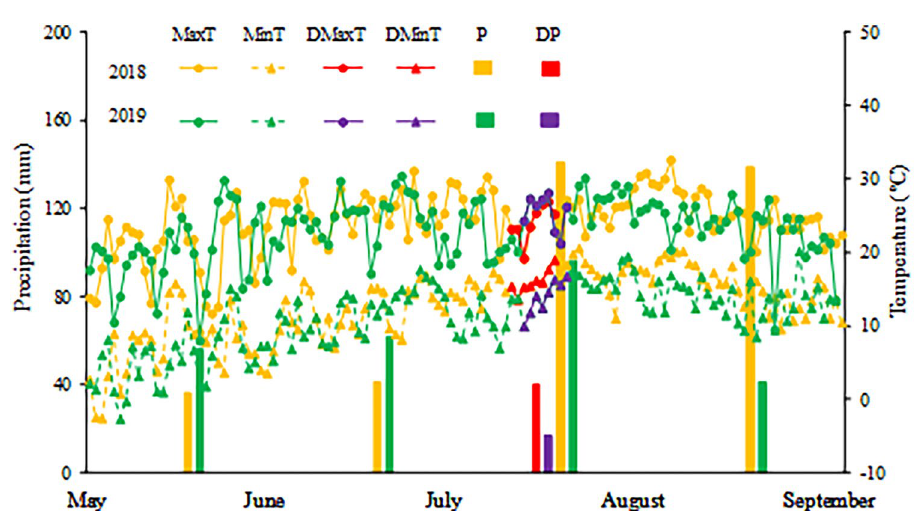
Figure 1. The maximum temperature (MaxT), minimum temperature (MinT) and month total precipitation (P) during the naked oat growing season, and maximum temperature (DMaxT), minimum temperature (DMinT) and total precipitation (DP) during the drought stress periods in 2018 and 2019 in the Bashang area, Hebei Province,